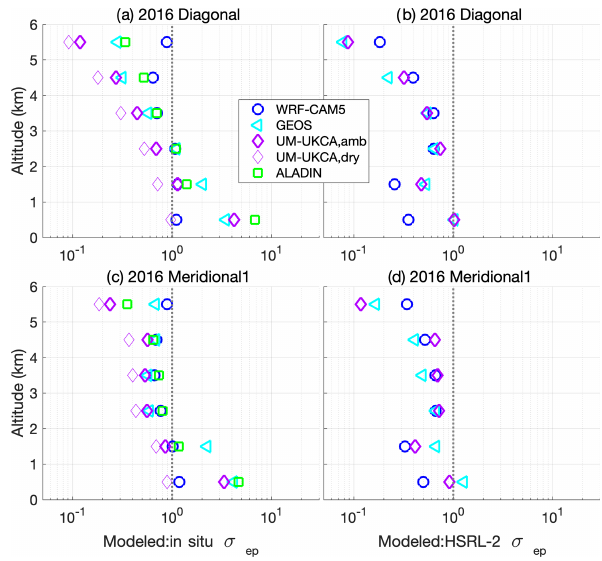
Figure 14. Mean ratio of modeled-to-in-situ low RH (a, c) and HSRL-2 ambient RH (b, d) mid-visible σ ep across all grid boxes for the 2016 diagonal (a, b) and meridional 1 (c, d) comparison transects. Comparisons to both dry and ambient RH σ ep are shown for the UM-UKCA model; for all other models, the comparison is to ambient RH σ ep . The ratios for individual grid boxes, along with these means, are given in the Supplement (Fig. S15 for WRF- CAM5, Fig. S17 for GEOS, Fig. S19 for UM-UKCA, and Fig. S21 for